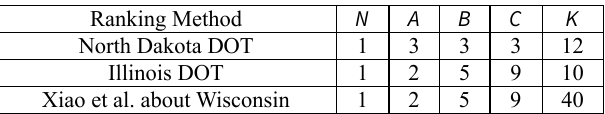
Table 2. Used-in-practice Crash Severity Ranking Methods with Applied